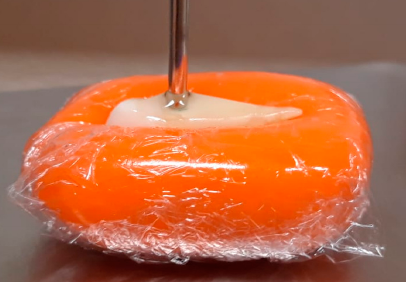
Figure 4. Example of dielectric properties measurement using a coupling medium: a drop of the coupling medium is placed on the tooth surface during the measurement.